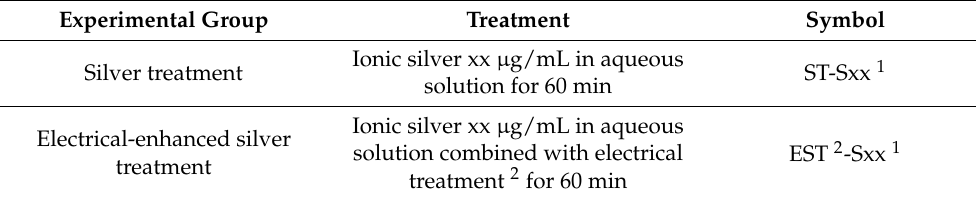
Table 1. Details of experimental treatments.